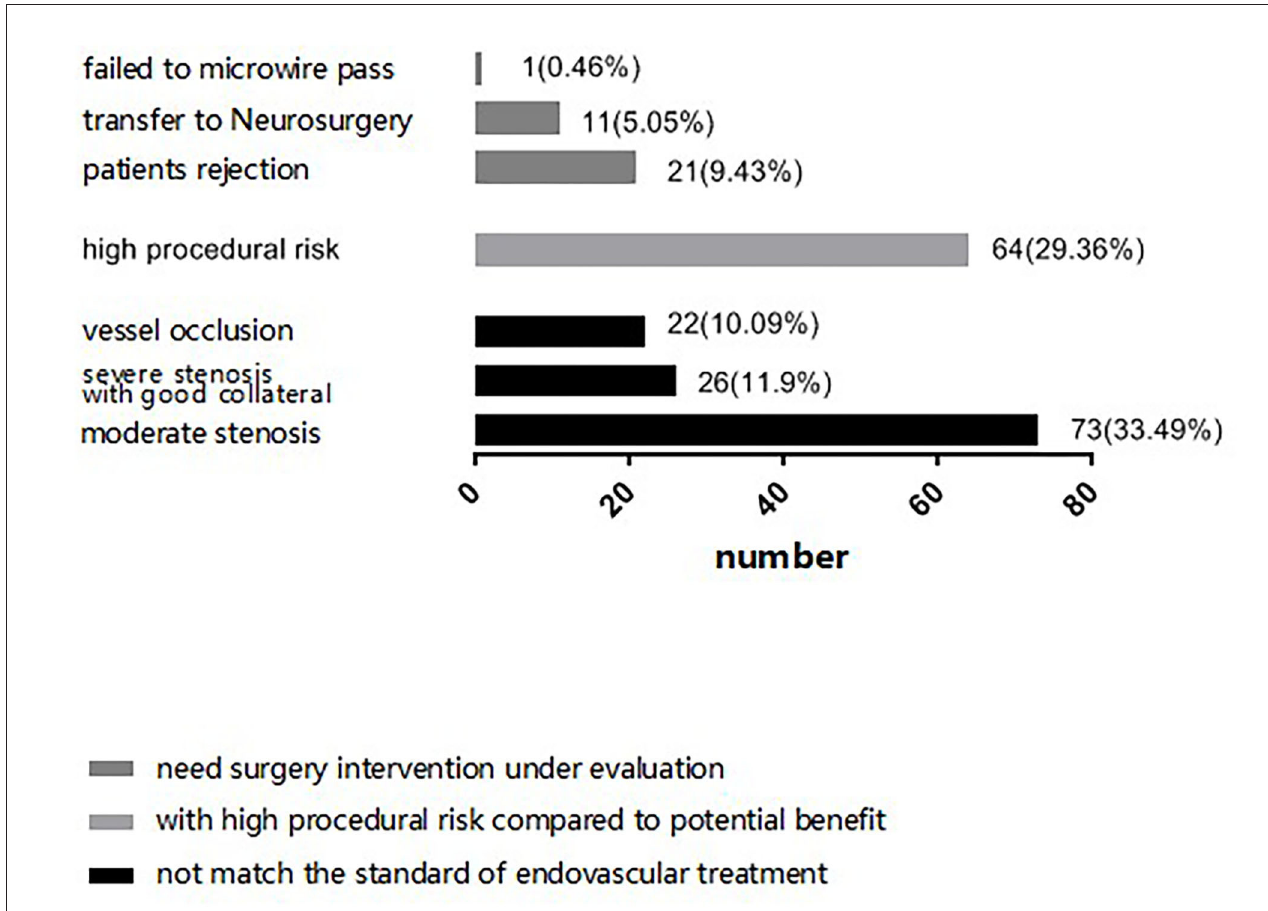
FIGURE 2 | Various reason of failing to further endovascular